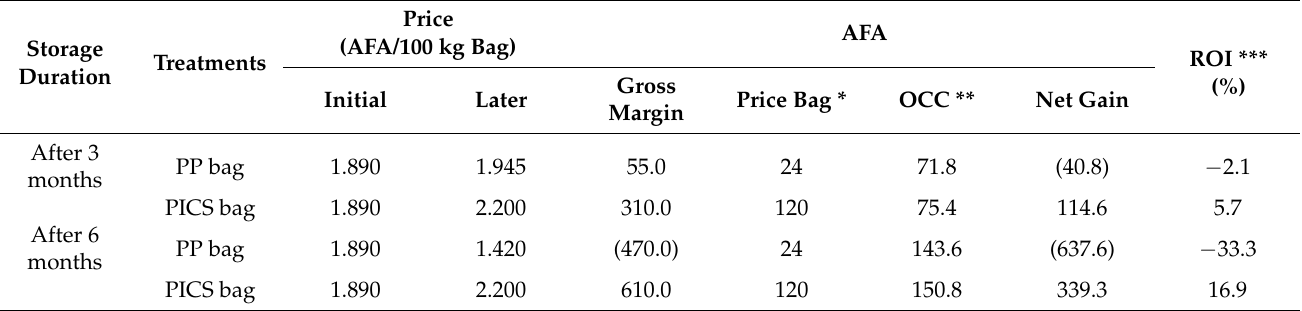
Table 4. Estimates return on investment (ROI) when wheat flour was stored for six months using 100 kg Purdue Improved Crop Storage (PICS) and polypropylene (PP) bags in Herat, Afghanistan. Grain and storage bag prices are in Afghani